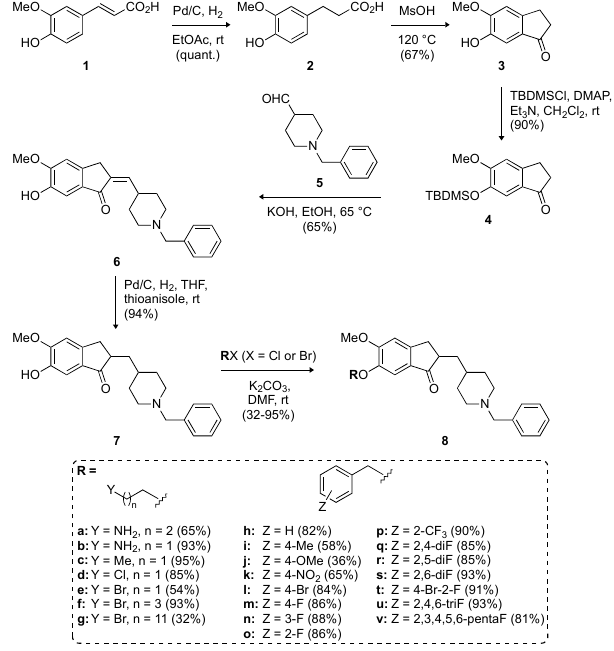
Scheme 1. Synthetic scheme for the preparation of compounds 8a – v .